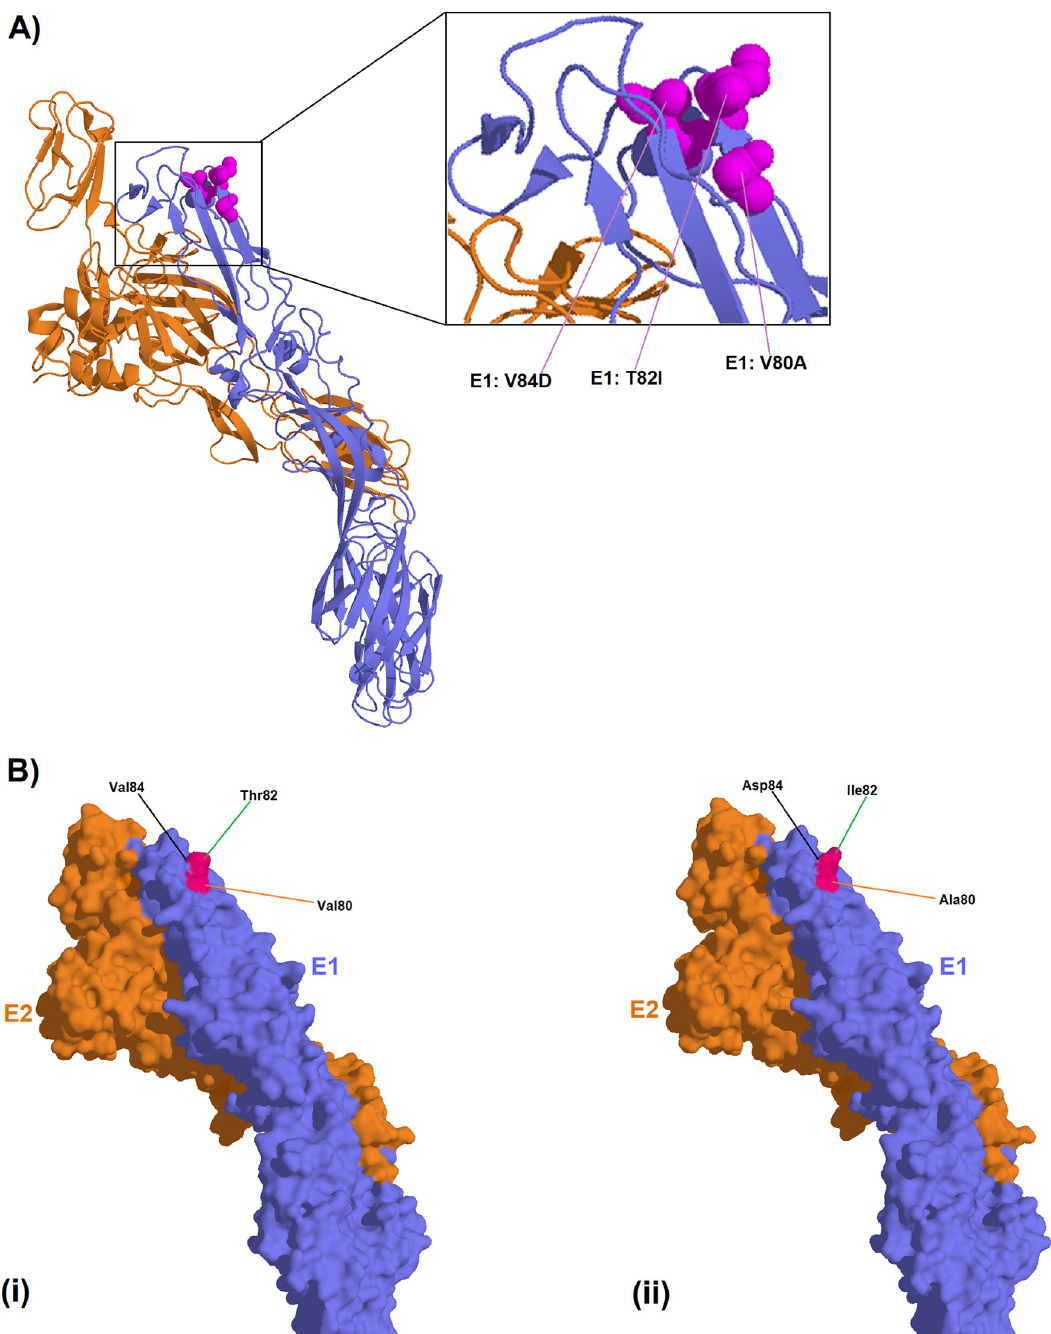
Fig 3. Protein figures showing; A) ribbon representation of CHIKV E1-E2 heterodimer (ID: 3N42) with the E1 monomer represented in blue and the E2 monomer represented in orange. Amino acid residues with potential functional significance are represented in spheres within the figure. B) Surface representation of the same E1-E2 heterodimer showing, i) wild type amino acids and ii) the reported mutations.